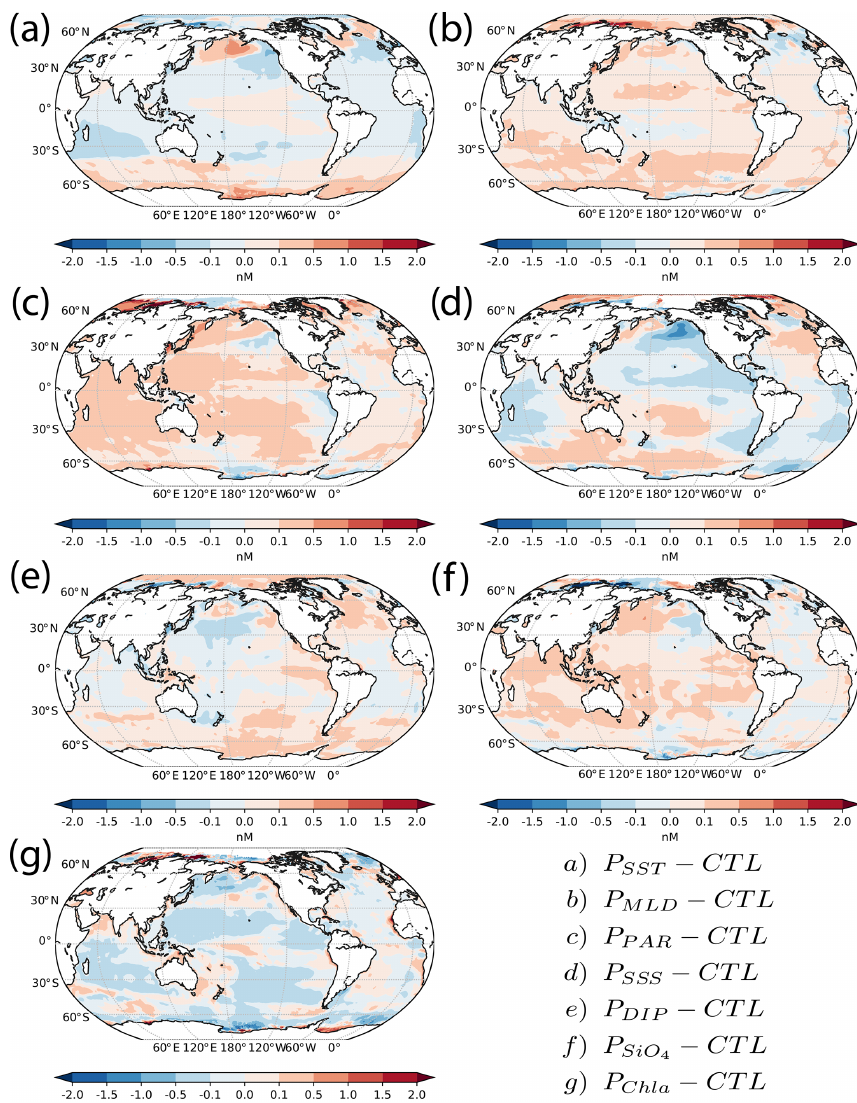
Figure 9. Differences of annul mean DMS concentration between perturbation models and the control model. Specific figure indexes are listed in the figure, where P xxx represents a perturbed model and the subscript xxx indicates which parameter is changed. CTL is the control model that is the average of our top 10 model results (Fig.